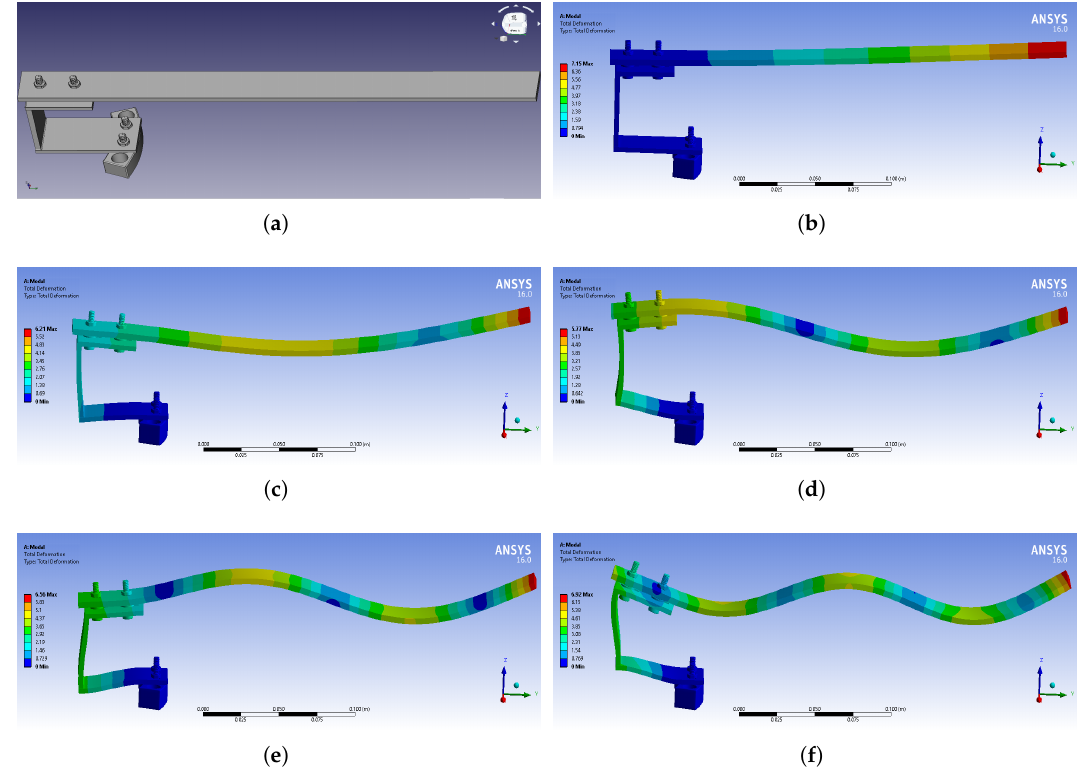
Figure 9. ( a ) View of the assembled rotating blade along with the first 5 bending modes of it on the easy axis, as they were calculated using ANSYS simulations: ( b ) 1st, ( c ) 2nd, ( d ) 3rd, ( e ) 4th, ( f )